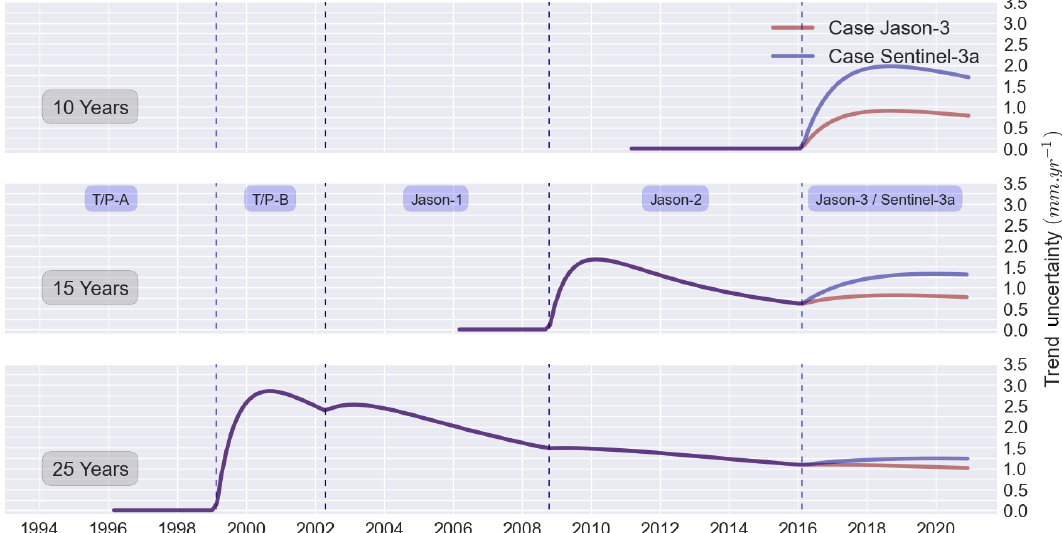
Figure 2. Impact of North Atlantic mean sea level inter-mission linking bias uncertainties on the estimation of the MSL trend over 10 years (upper panel), 15 years (middle panel), and 25 years (lower panel), in the cases of Jason-3 and